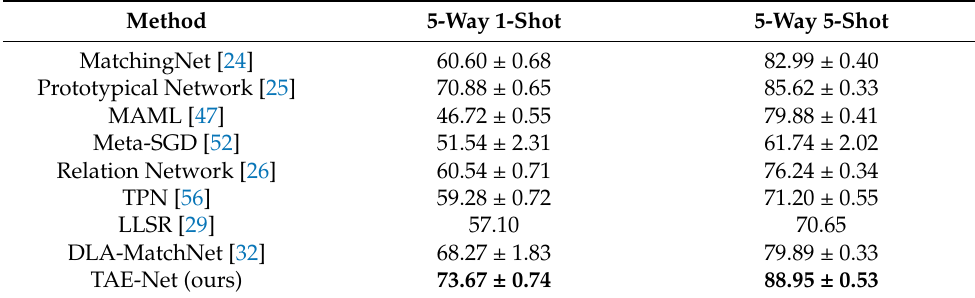
Table 3. Classification accuracies and standard deviations (%) of 5-way 1-shot and 5-way 5-shot on the WHU-RS19 dataset. The best results per scenario are marked in